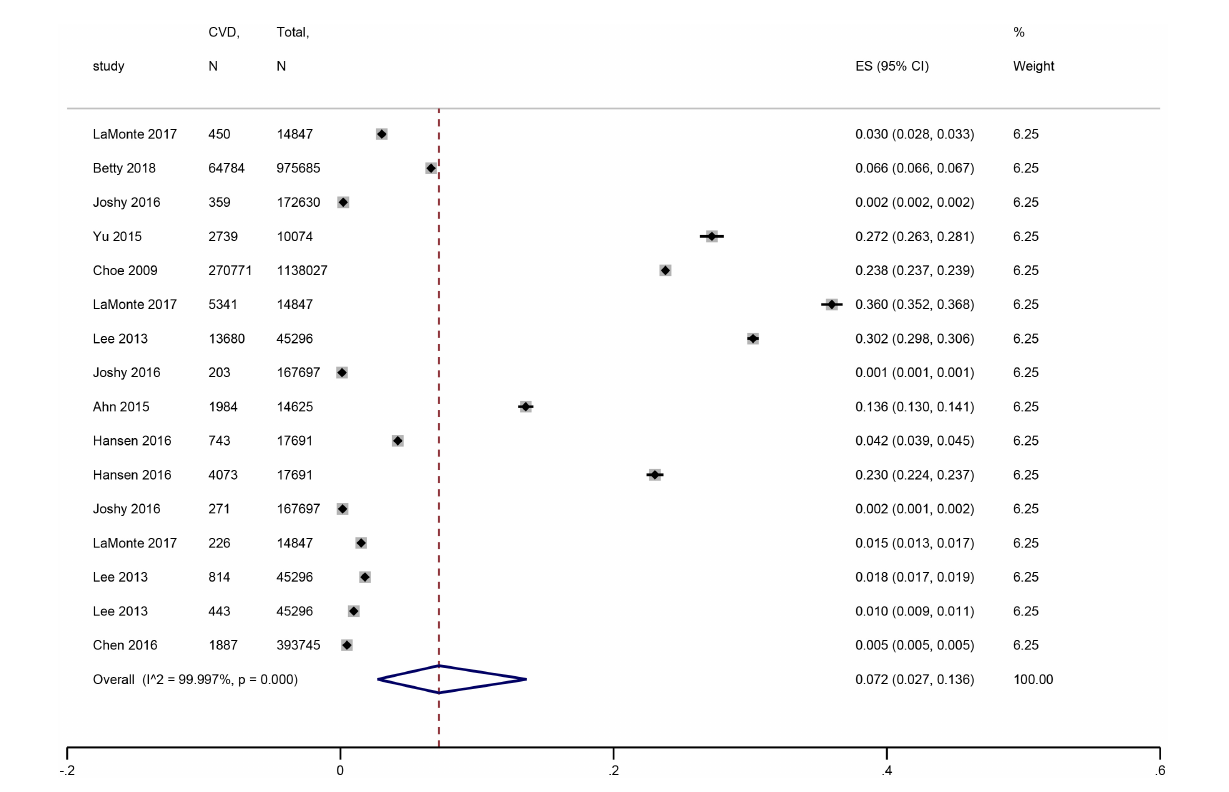
stroke (16, 17, 22, 25, 26, 30, 33, 34) in both male and female periodontal disease patients (OR = 1.29, 95%